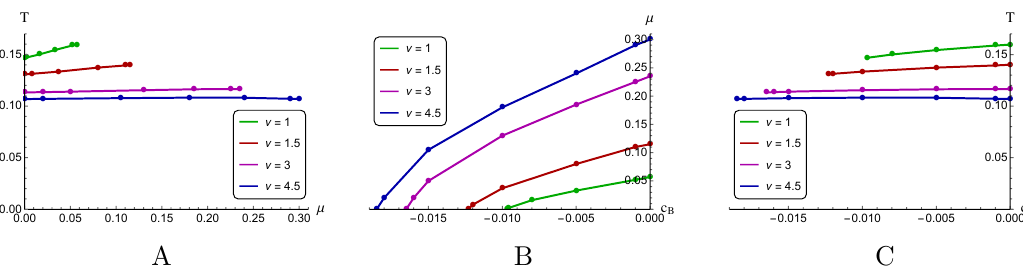
Figure 10 . Position of critical end-points CEP HQ for heavy quarks model depending on µ and T (A), c B and µ (B), c B and T (C) for ν = 1 , 1 . 5 , 3 , 4 . 5 , c = 0 . 227 . T and µ are in units of GeV, and c B of GeV 2 .